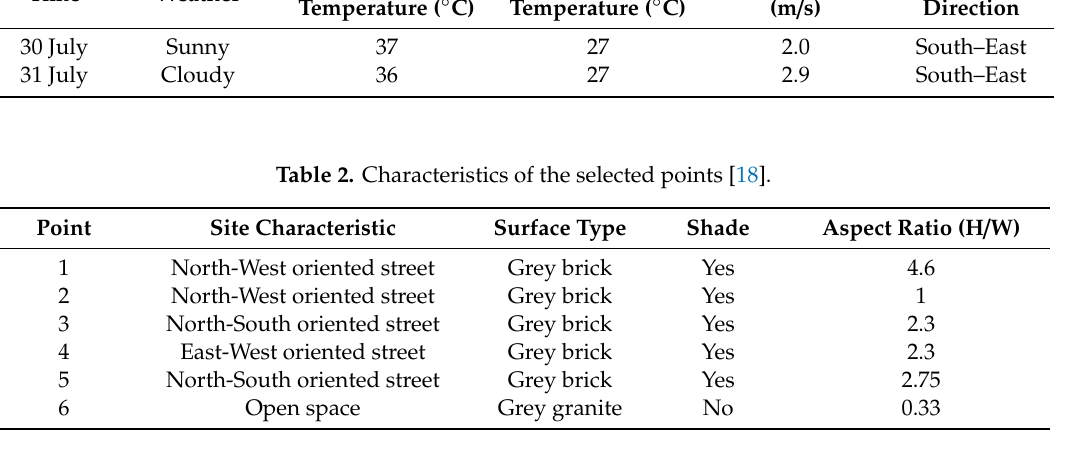
Table 1. Meteorological data on 30 and 31 July 2016.